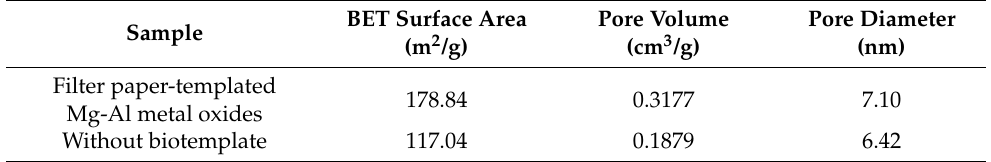
Table 1. BET specific surface area (SSA), pore volume, and pore diameter of different samples.